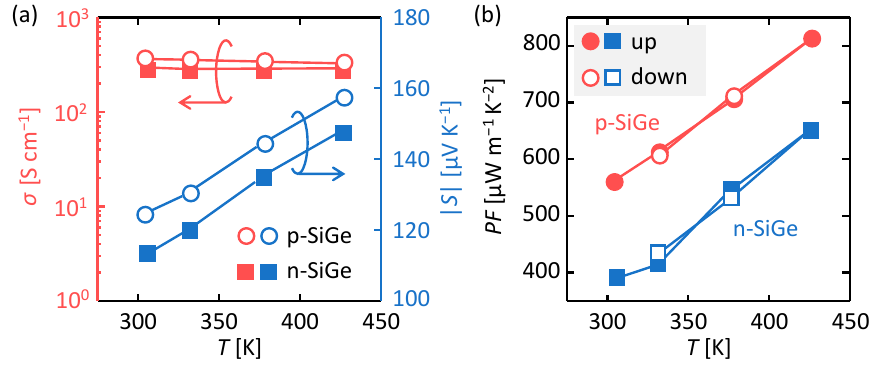
Figure 3. Thermoelectric properties of the p- and n-type SiGe samples formed by LE using Al and Ag:As as a function of measurement temperature ( T ). ( a ) Electrical conductivity σ and Seebeck coefficient S and ( b ) power factor ( PF ). The data points are averaged values of three measurements, and the error is within acceptable limits.